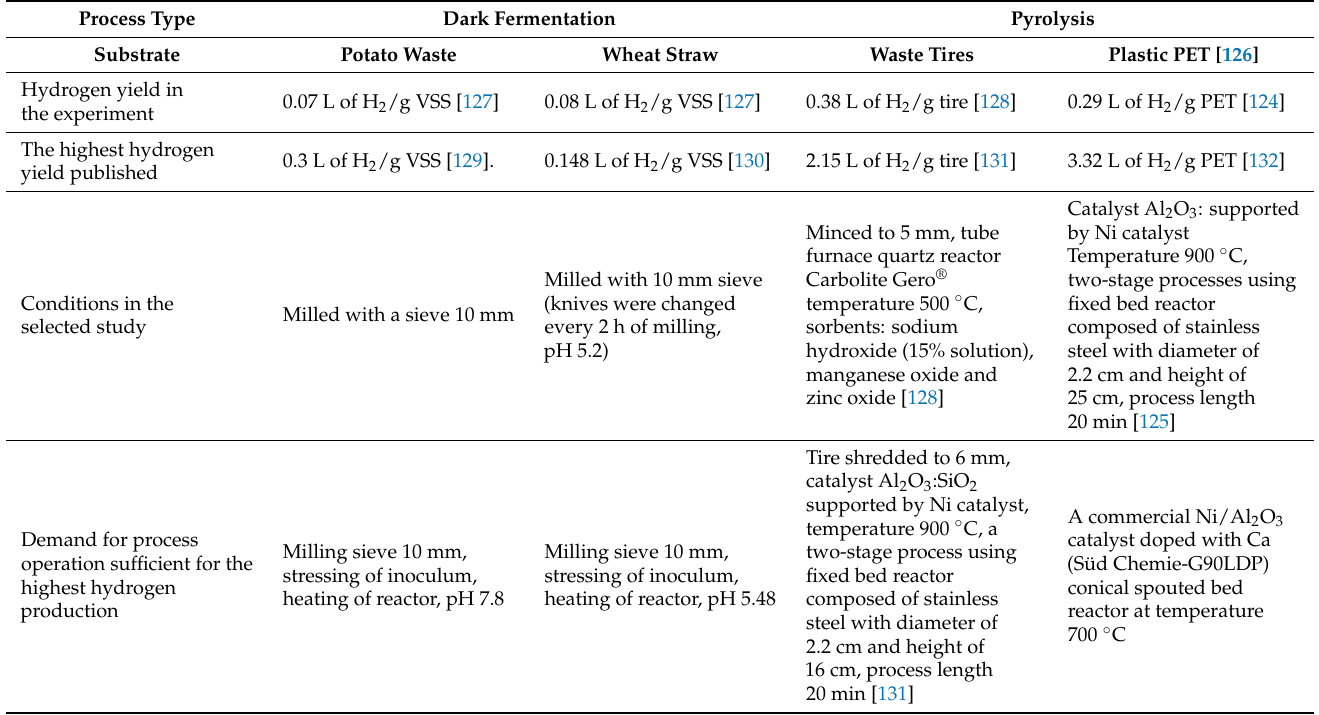
Table 6. Comparison of hydrogen production from wheat straw and potato waste by dark fermenta- tion and pyrolysis of waste tires and